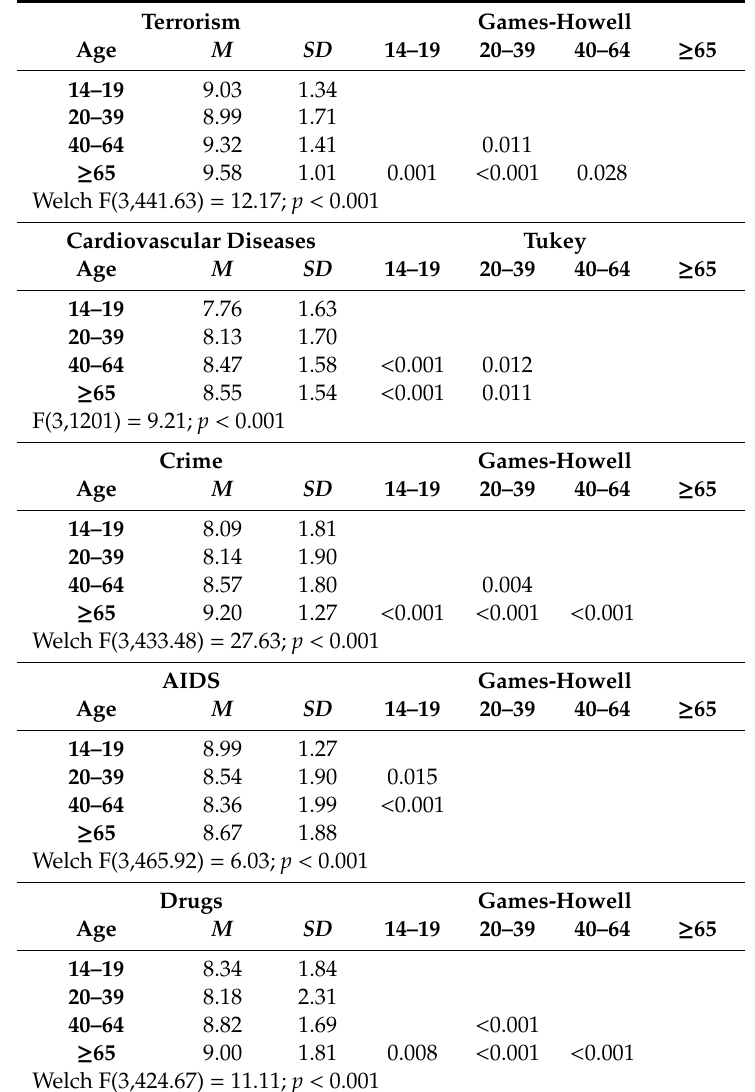
Table 5. Post hoc analysis for age di ff erences in the evaluation of social and health